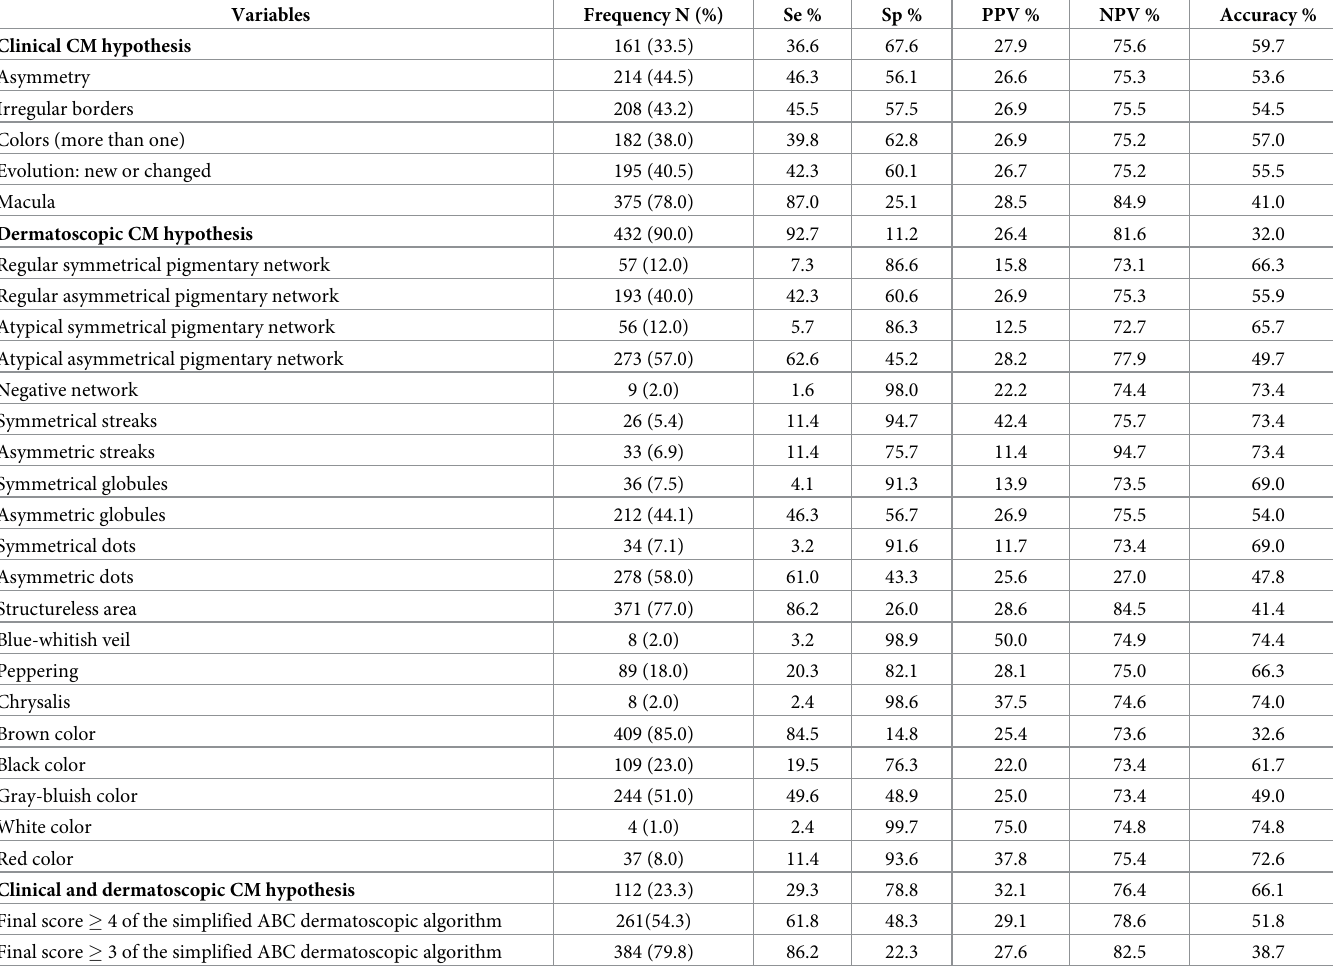
Table 4. Validity of clinical and dermatoscopic criteria of 481 lesions � 6mm in